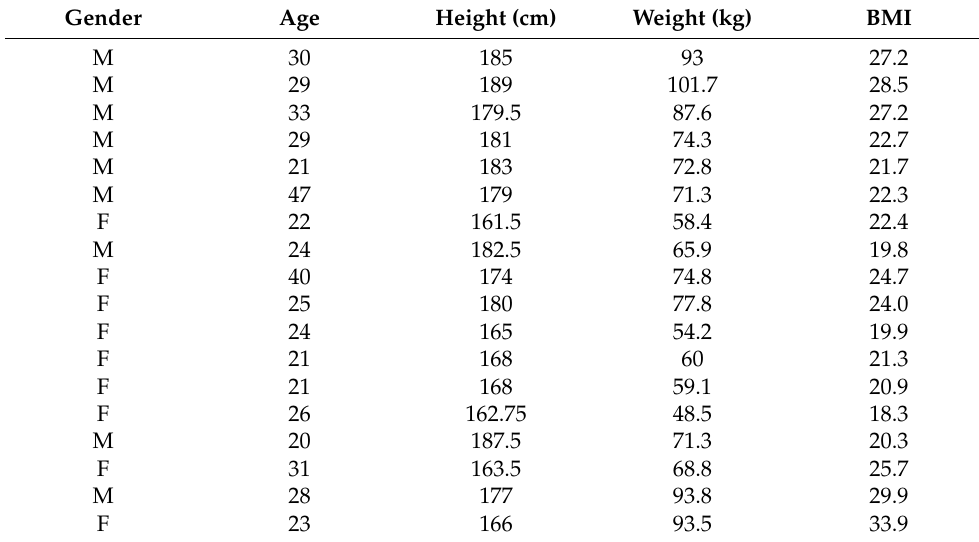
Table 1. Biometric information of the cohort of